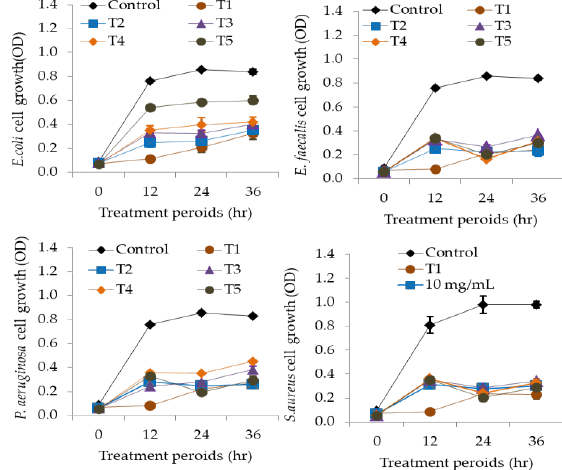
Figure 1. Antibacterial activity of lyophilized ECS of KCC-51 at the different concentrations and time incubation. Data are expressed as the mean ± S. E.M. of five replicates. The analysis was performed with three technical replicates from each sample. T1—20 mg / mL, T2—10 mg / mL, T3—5 mg / mL, T4—2.5 mg / mL, and T5—1.25 mg / mL of lyophilized ECS.